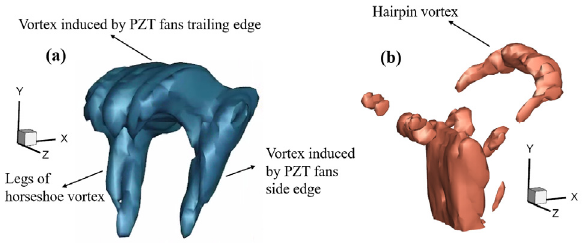
Figure 13. Typical flow structures generated by PZT fan: ( a ) a CW horseshoe vortex at τ = 0.25, ( b ) a hairpin vortex at τ = 0.375.